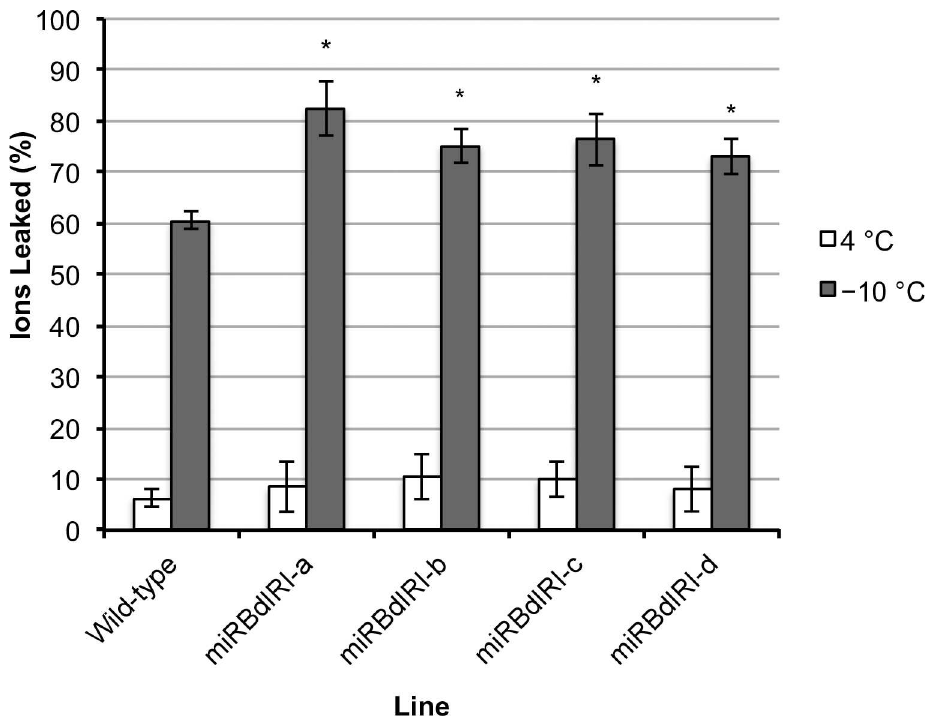
Fig 11. Ion-leakage assaysconducted using leaf tissue from cold acclimated wild-type B . distachyon and miRBdIRI knockdown lines. Controls were kept at 4˚C (open bars) and treated samples (dark bars) were frozen to a final temperature of − 10˚C over a 4 h periodbefore assayed for ion leakage(%). Error bars representstandard error of the mean with significancedenotedby an asterisk and indicating p < 0.005 (unpairedT-test, one-tailed). Experiments were done in triplicate (n = 10).